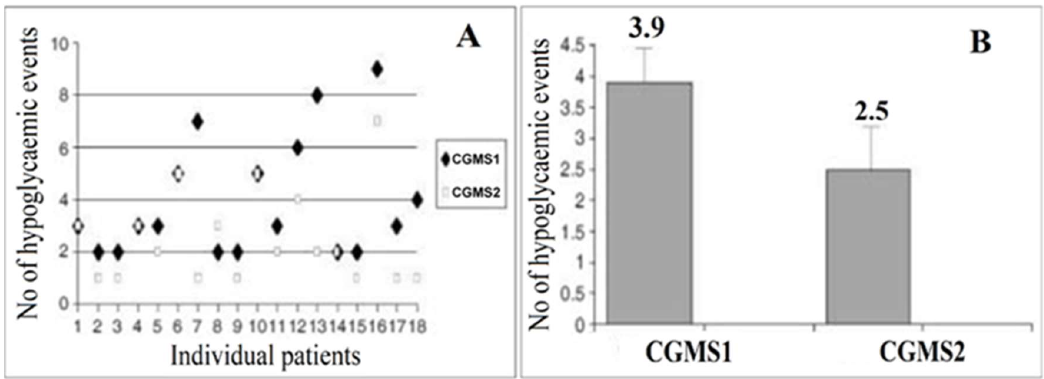
Figure 26. Number of hypoglyceamia events ( A ), ( B ) median number of hypoglyceamic